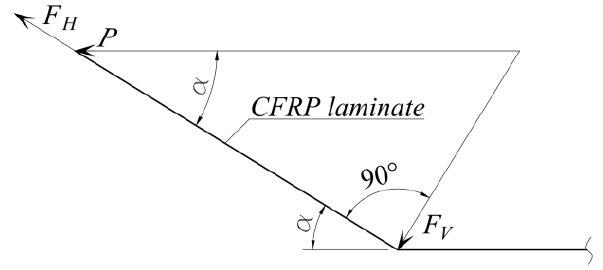
( c ) Figure 8. Tensile test simulation with Ansys: ( a ) pressure and tension simultaneously, ( b ) eccentric load action, e = 0.25 b f , and ( c ) eccentric load action, e = 0.125 b f. Thus, it can be seen from Figure 8a that when pressure and tension work together, a high concentration of stress occurs at the anchoring equipment, which leads to premature failure of the element. Therefore, such an anchoring method with forced bending of the laminate is unacceptable. The effect of an eccentric force was also simulated (Figure 8b,c). According to previous research conducted at Vilnius Gediminas Technical University, such an eccentric effect can be caused by the tension of the anchor device used for pre-tensioning the laminate instead of pushing. Figure 8b,c shows two cases of eccentricity with high ( e = 0.25 b f ) and low ( e = 0.125 b f ) eccentricity; although the stress concentration differs by 1.5 times,